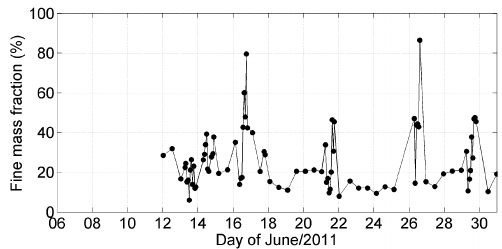
Figure 15. Fine mass fractions were obtained by dividing the mass concentrations of the fine mode by that of the total (fine + mixed) modes collected on filters using the LACO aerosol sampling station during the Fennec experiment at SS1 Algeria. Two main peaks were observed on 16 and 26 June, indicating the lower concentration of coarse